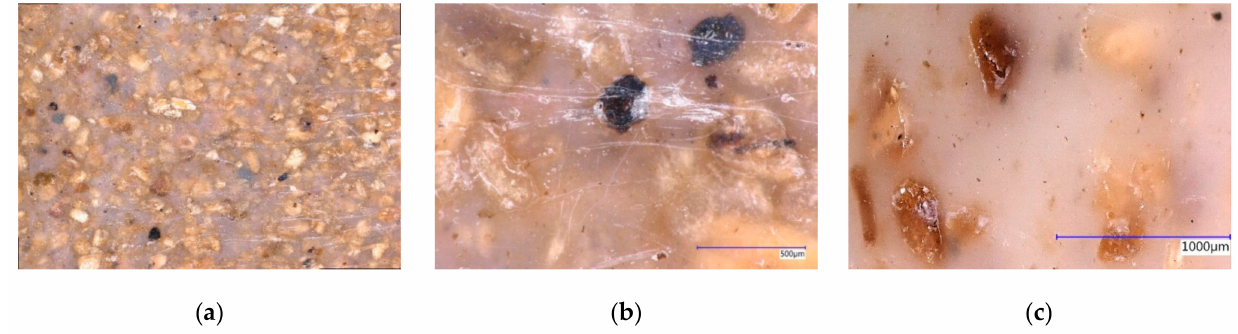
Figure 3. ( a ) 9:1-c-25-1.0, panorama mode, 7 × 10 mm; ( b ) 9:1-c-25-1.0 showing a burnt particle destroying the surface, magnification 200 × , 3D mode; ( c ): 9:1-c-16.7-1.0 showing the rough surface, due to embedded particles, magnification 100 × , 3D